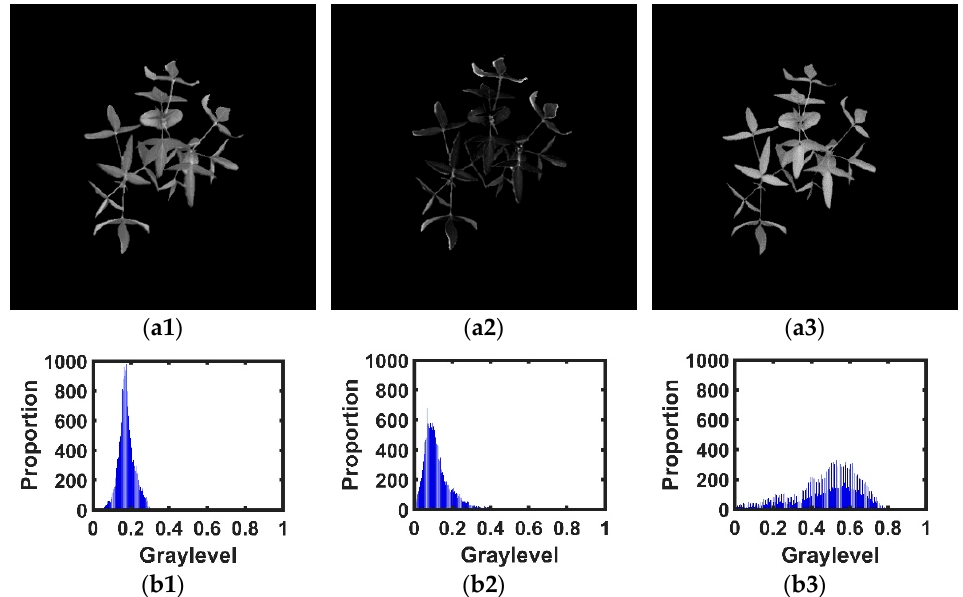
Figure 12. Extraction effect and corresponding histograms of the soybean canopy under drought treatment: ( a1 ) GRE target image, ( a2 ) RED target image, ( a3 ) REG target image, ( b1 ) GRE histogram, ( b2) RED histogram and ( b3 ) REG histogram.